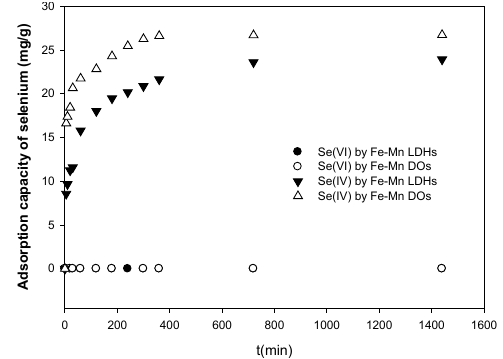
Fig. 4. Adsorption kinetics of Se(IV), Se(VI) by Fe-Mn LDHs and Fe-Mn